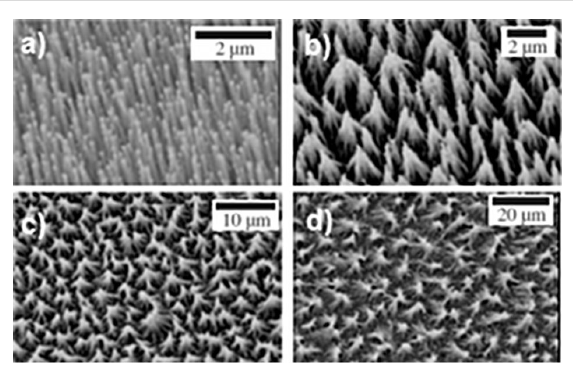
Figure 24: SEM images of superhydrophobic CNT forests, after func- tionalization with thiols: (a) in the gas phase; (b-d) in ethanol, for increasing initial nanotube length, resulting in characteristic lateral roughness length scale L : 1.7, 3.5 and 6 μ m (pictures b, c and d). Adapted with permission from [178]. Copyright 2006 American Phys- ical